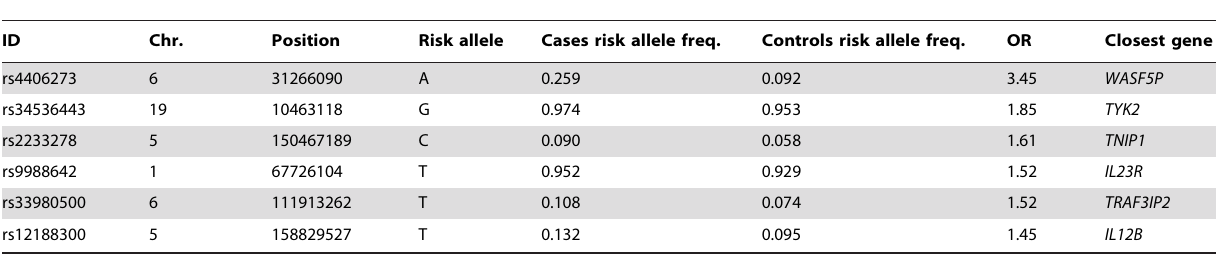
Table 1. Selection of previously identified risk alleles for psoriasis.